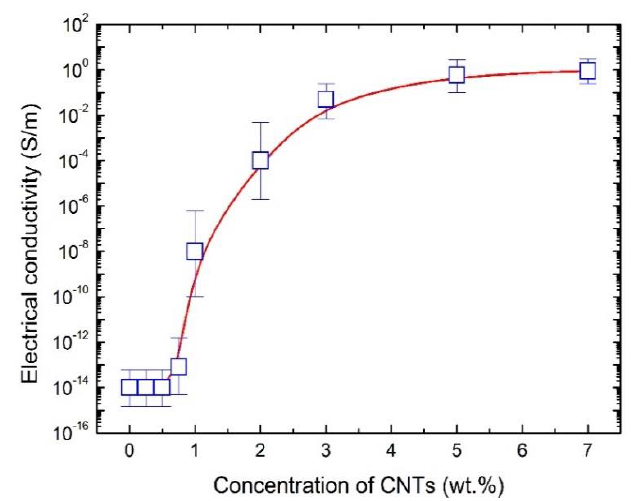
Figure 3. Electrical conductivity of CNT / PU coatings as a function of CNT concentrations.